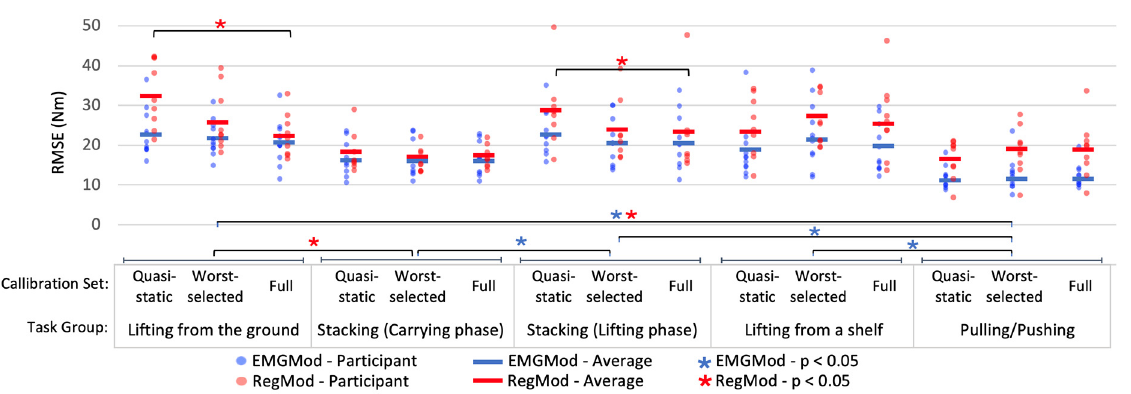
Figure 6. Averaged across participants RMSEs of EMGMod and RegMod for different calibration sets. RMSEs depended on the number of lifting trials included in the calibration sets and on the characteristics of the included trials. The dashed line represents the reference RMSE that was attained by Full calibration. The number of trials included in the calibration sets was increased until the RMSE of RegMod approached the reference RMSE. The family of Selected sets, which was chosen based on the selection criterion, resulted in RMSEs within a close range of the reference RMSE. The Quasi static set resulted in larger RMSE than Full set.